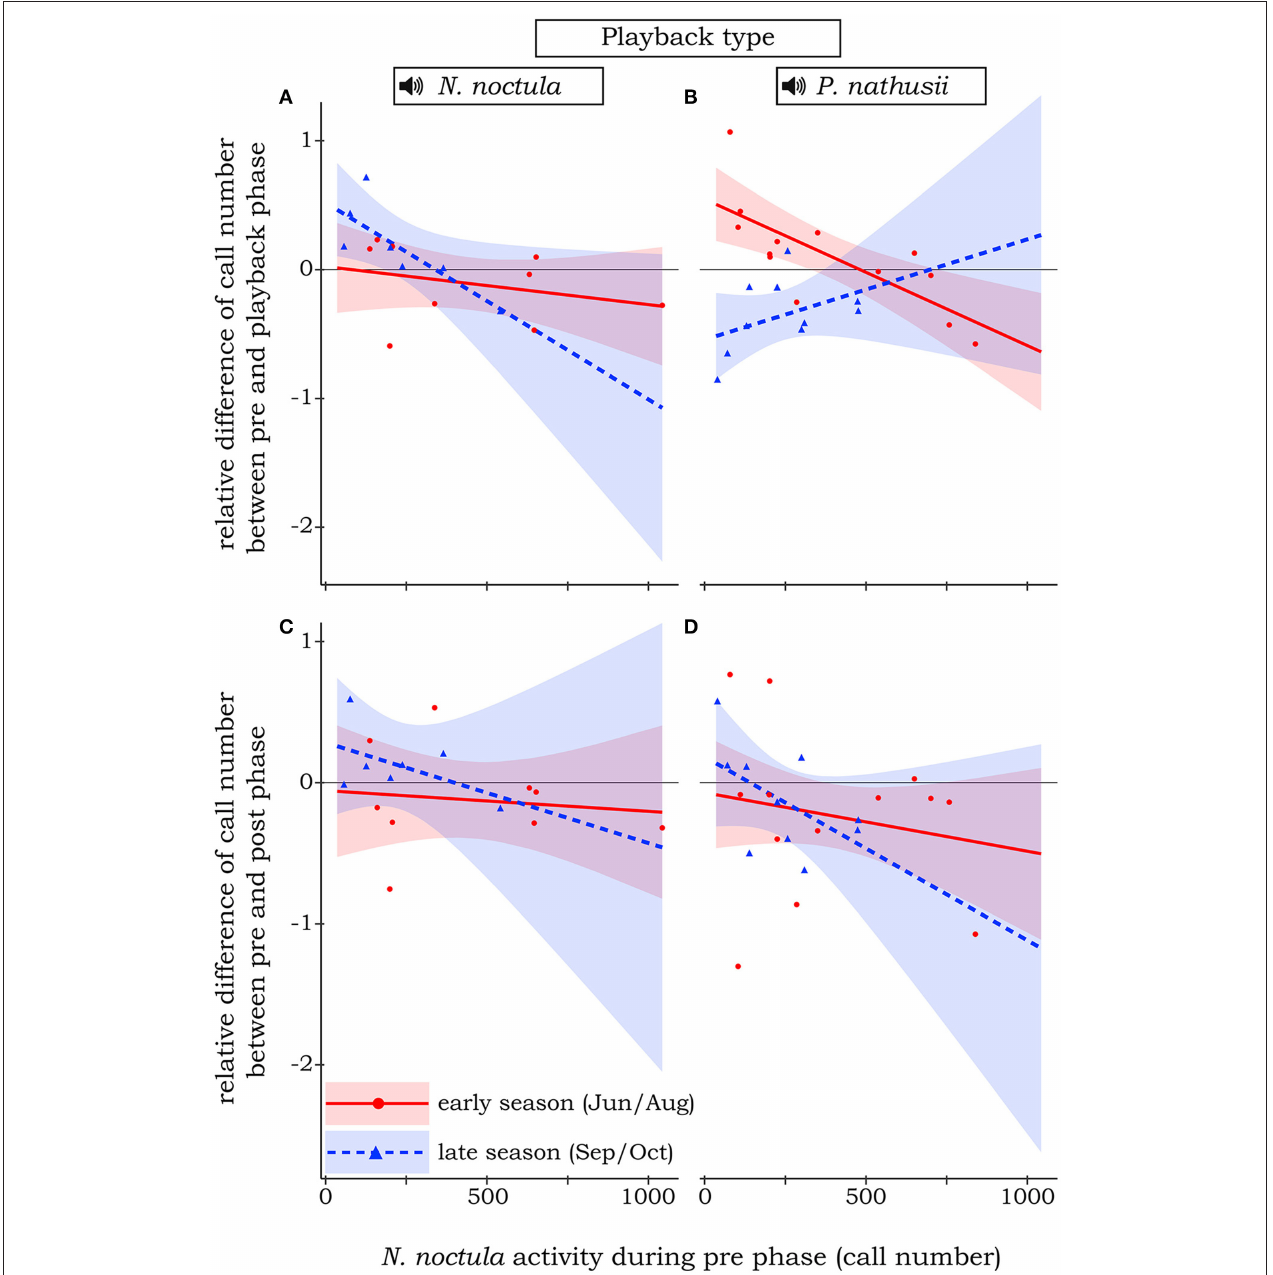
FIGURE 2 | Relative difference of N. noctula activity between pre-phase and playback phase (A,B) or the pre-phase and post phase (C,D) of the experiment, depending on N. noctula activity during the pre -phase, the different playback types, and the season. Raw data is depicted by circles and triangles. Lines show the estimated effect, shaded areas show the corresponding 95% confidence intervals. Solid red line and red circles: early season. Dashed blue line and blue triangles: late season. For simplicity, insignificant effects toward the control treatment (sine tone) are not